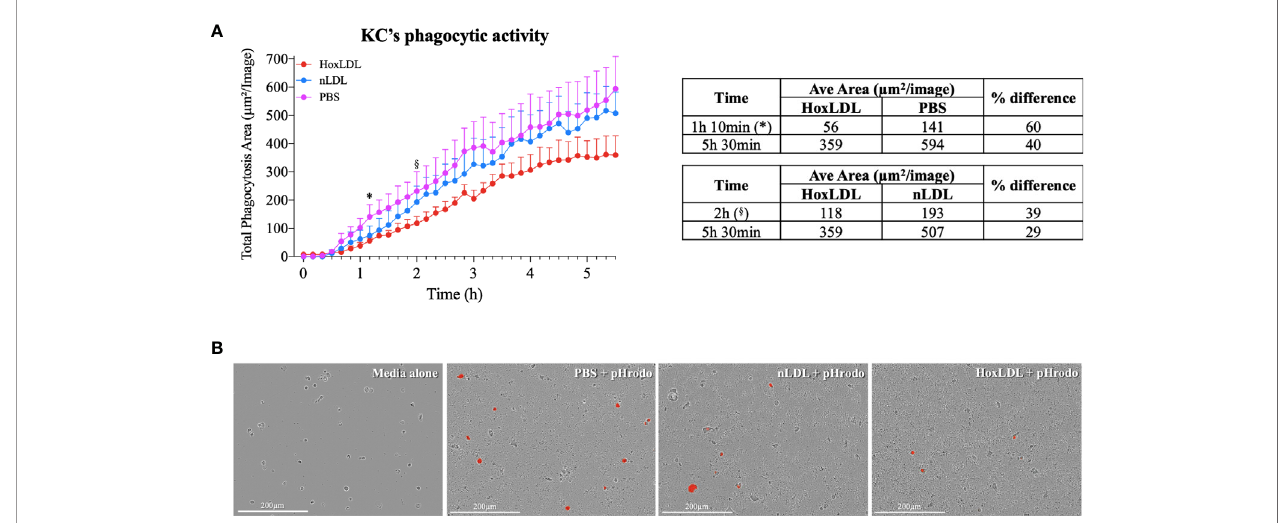
FIGURE 4 | HoxLDL inhibits human Kupffer cells ’ phagocytic activity. (A) HoxLDL exposure impairs KCs phagocytic activity starting at 1h 10min (*) statistically different from to unstimulated KCs-PBS, (§) statistically different from nLDL stimulated KCs (n= 4) . Two-way ANOVA test was used to detect statistical signi fi cance among time points. (B) Representative images from live-cell image assay, pHrodo red E-coli bioparticles ® become fl uorescent inside the KCs ’ lysosomes. Human KCs stimulated by HoxLDL image display less fl uorescent-labeled cells, indicating phagocytic activity. Scale bar